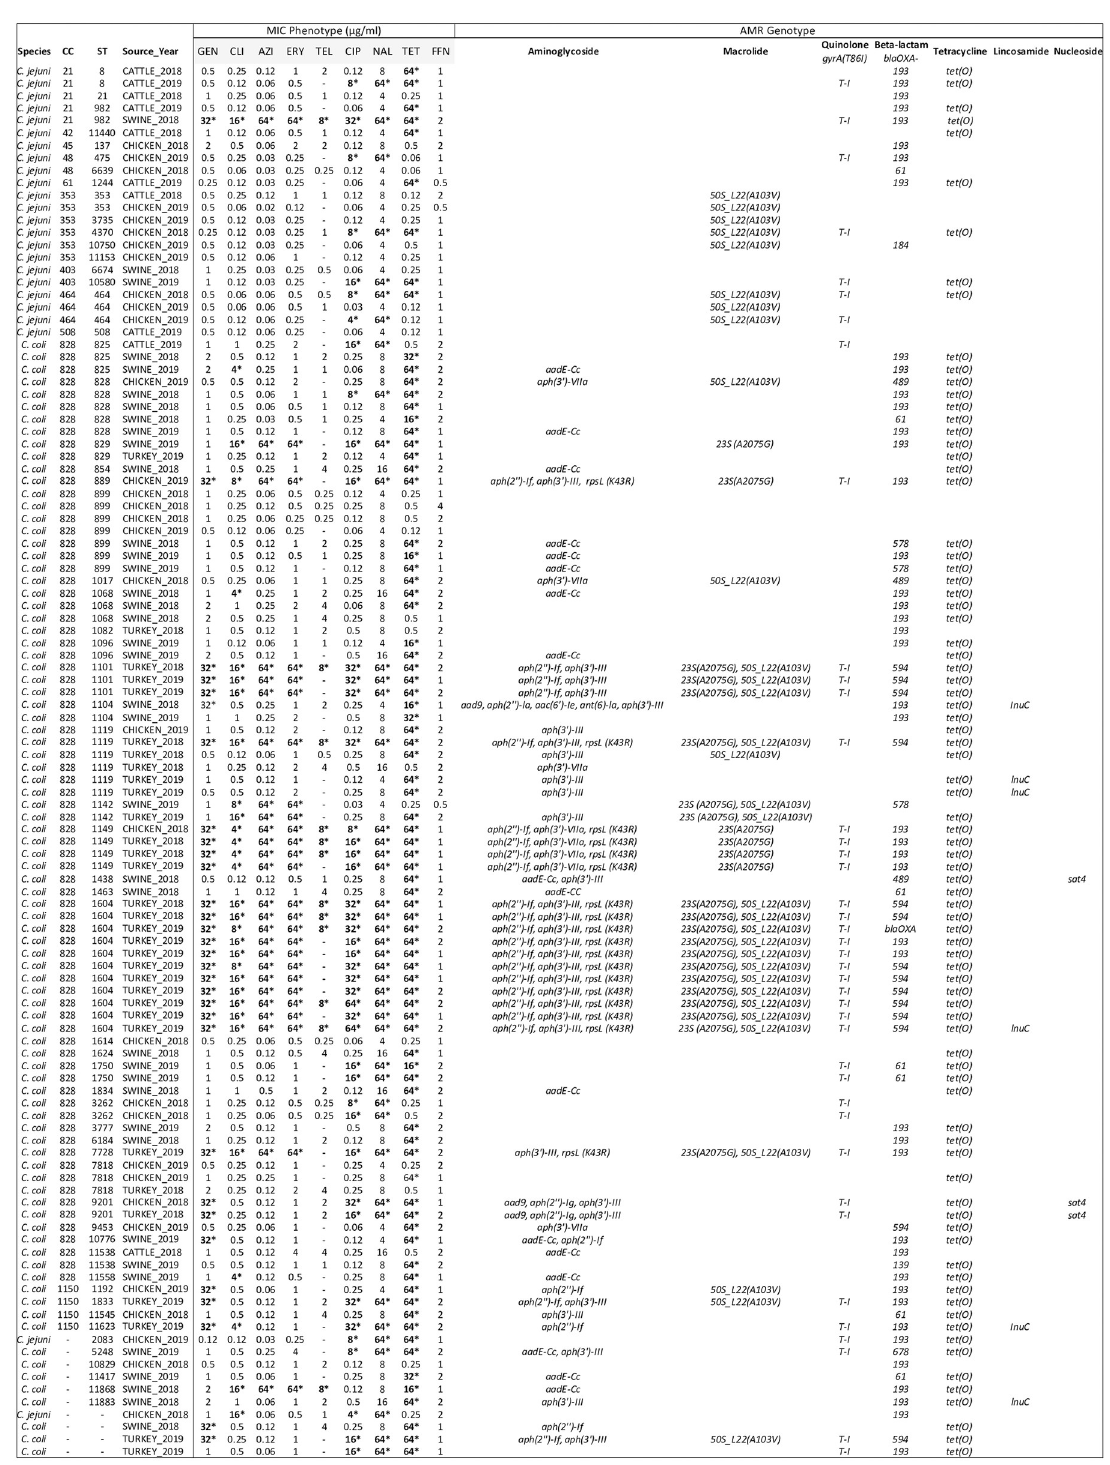
Fig 1. Campylobacter antibiotic susceptibility test results in live food animals aligned with AMR genotype, MLST, and source. Bold ( � ) = resistant. NARMS USDA-FSIS C . coli and C . jejuni minimum inhibitory concentration (MIC) results in μ g/ml concentration for live food animals in North Carolina compared with MLST and AMR genotype. MIC was determined for the following antibiotics: Gentamicin (GEN), Clindamycin (CLI), Azithromycin (AZI), Erythromycin (ERY), Telithromycin (TEL), Ciprofloxacin (CIP), Nalidixic Acid (NAL), Tetracycline (TET), and Florfenicol